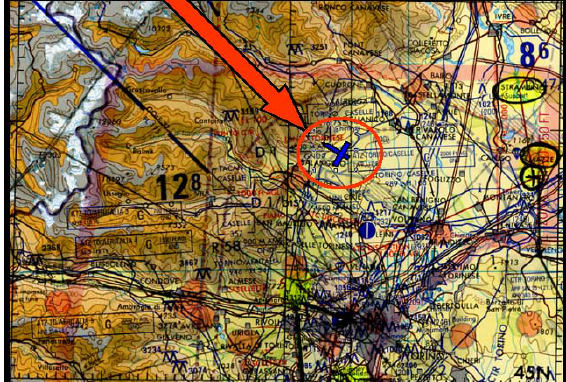
Fig 10. Interactive Navigation Map created in Altia Design environment